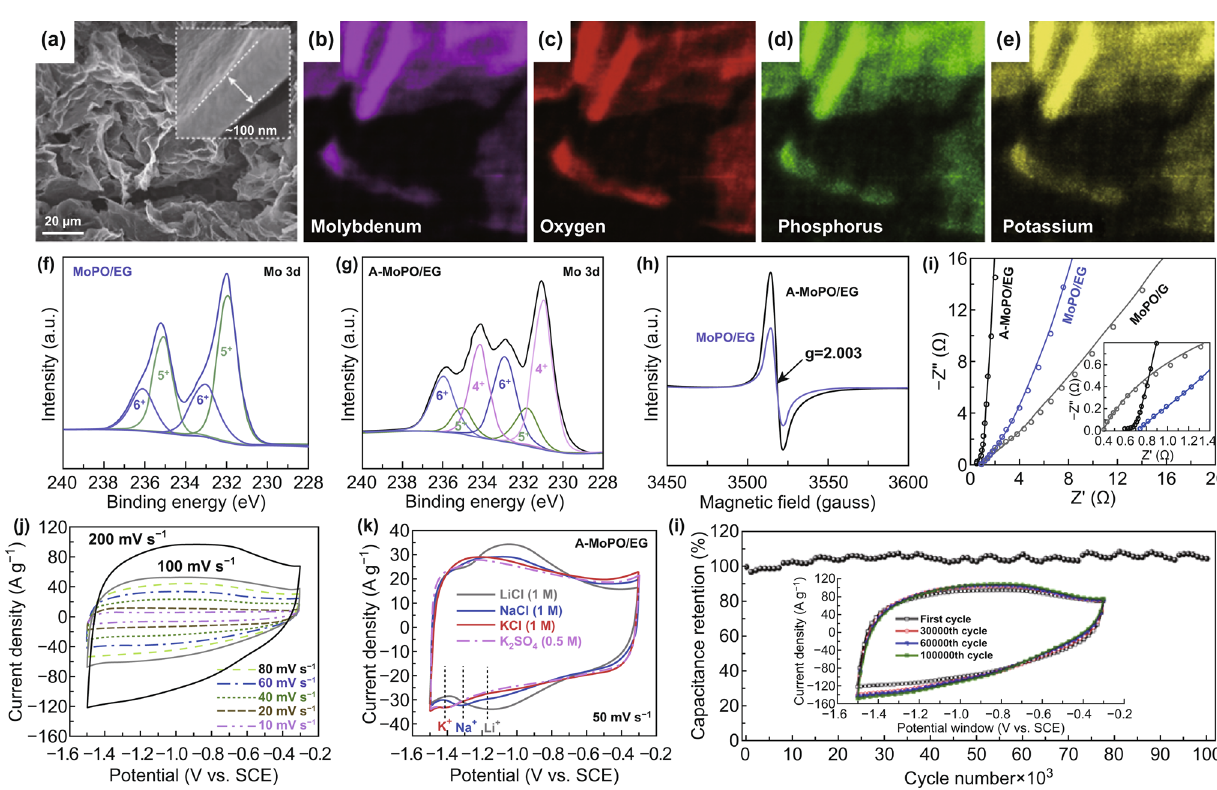
Fig. 32 a SEM image of activated polyanionic molybdenophosphate (A‑MoPO/EG) on electrochemically exfoliated graphite foil. Inset: Mag‑ nified view showing the thickness of A‑MoPO. b – e EDS elemental mappings of Mo, O, P, and K in A‑MoPO/EG. f , g Mo 3d XPS spectra of f MoOP/EG and g A‑MoPO/EG. h EPR spectra of oxygen deficiency signals of MoOP/EG and A‑MoOP/EG. i Nyquist plots of A‑MoPO/EG, MoPO/EG, and MoPO/non‑exfoliated graphite foil electrodes. j CV curves of A‑MoPO/EG at different scan rates in 3 M aqueous KCl electro‑ lyte. k CV curves of MoPO/EG recorded in various aqueous electrolytes. i Cycling stability of A‑MoPO/EG in 100,000 charge–discharge cycles. Adapted from Ref. [28] with permission